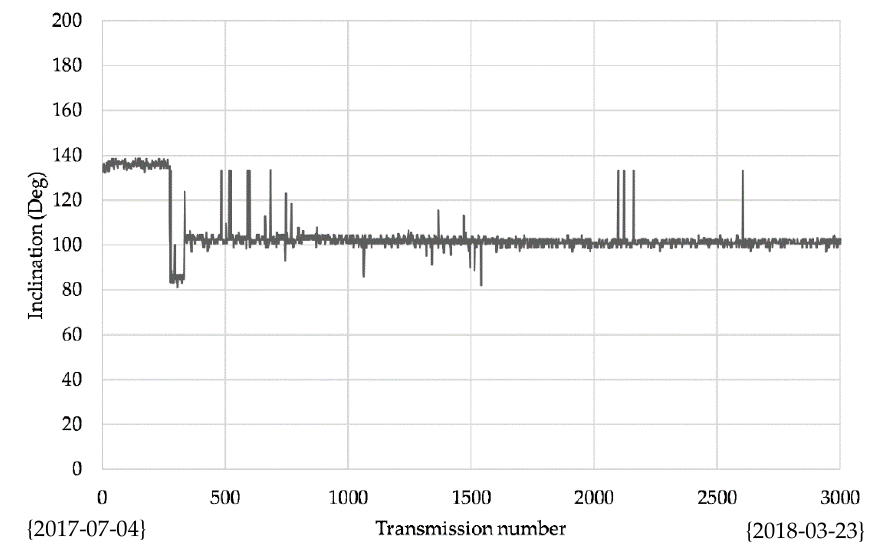
Figure 15. Example of application: acceleration data provided by the 3-axis accelerometer.